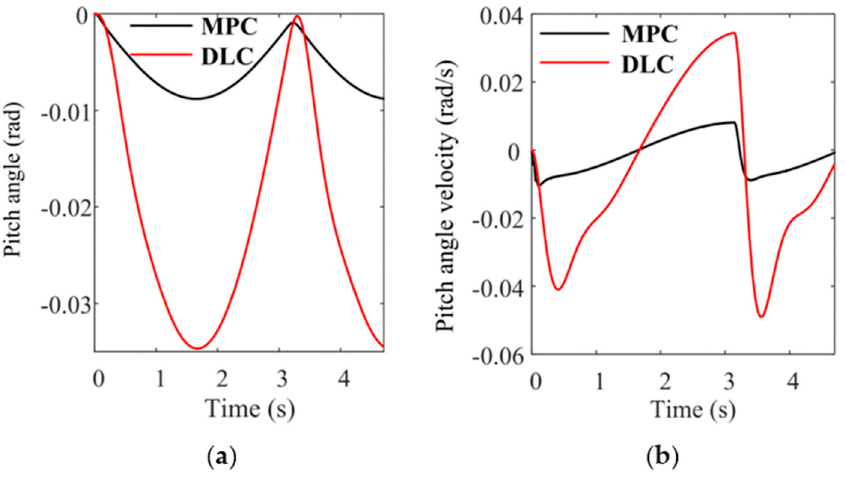
Figure 11. Body pitch angle and pitch angle velocity. ( a ) Body pitch angle; ( b ) Body pitch angle velocity.